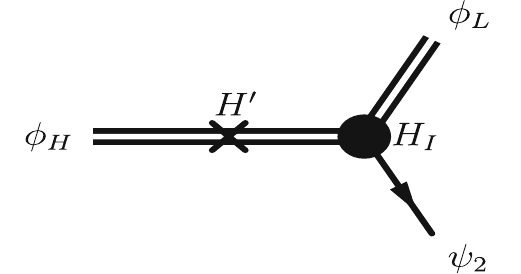
observation at a fixed time and position, it is emitted earlier [12]. There- fore φ H has less time to interact with the environment in A 2 α than in A 1